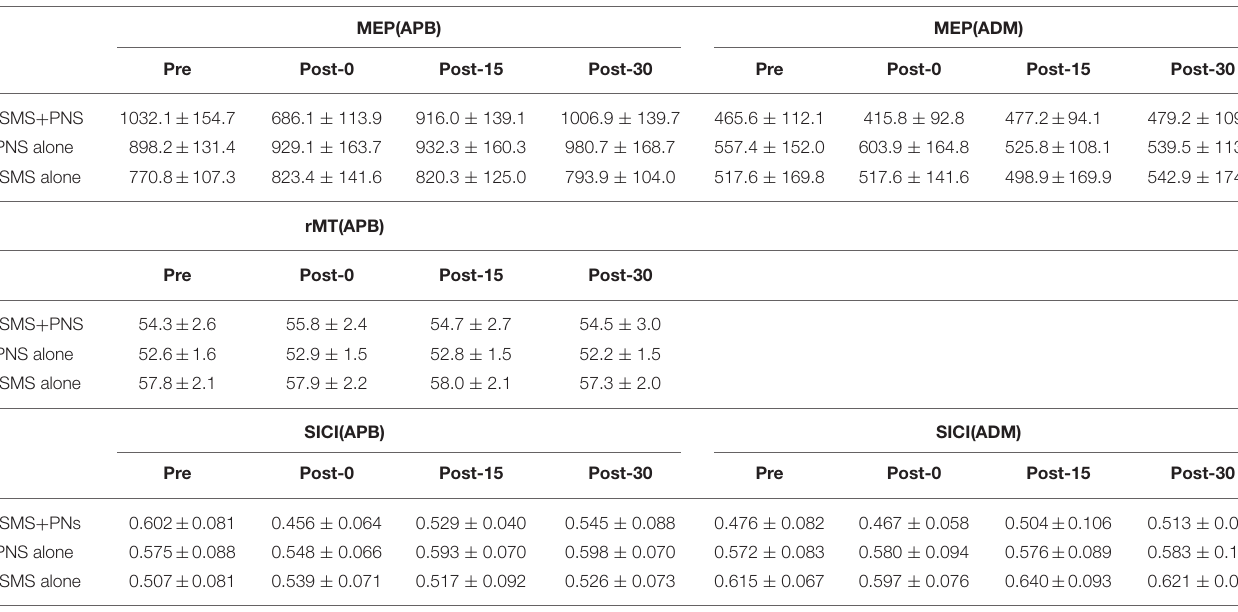
TABLE 1 | Changes of the time-course in TMS parameters for the right abductor pollicis brevis muscle.